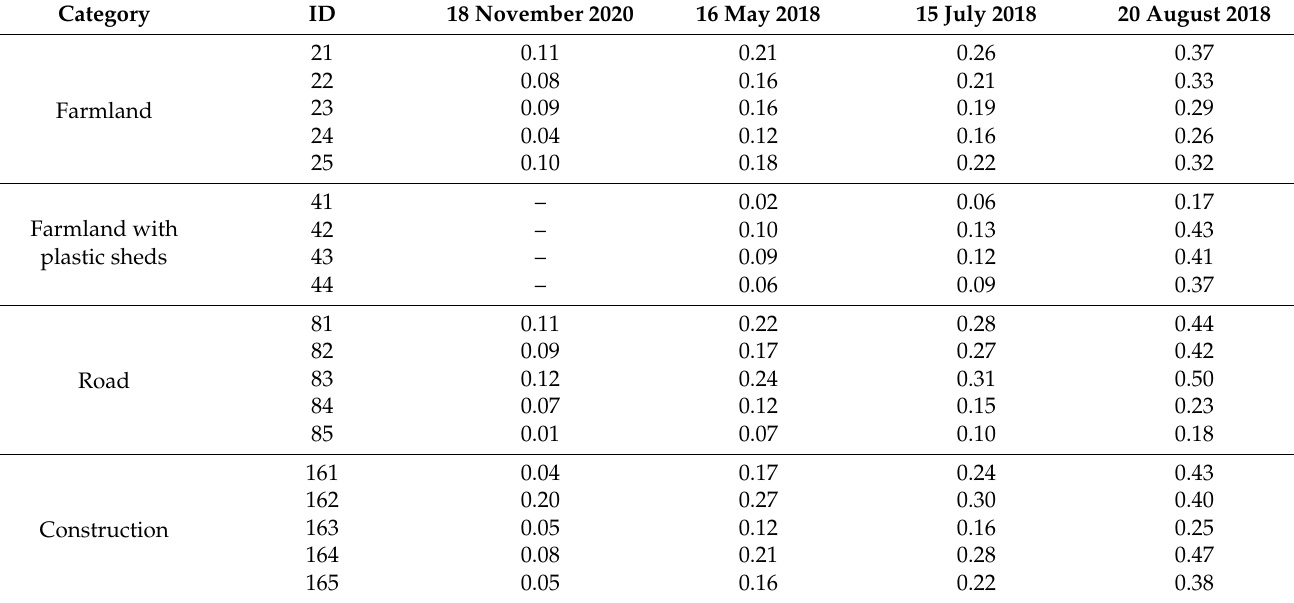
Table 7. Flood depths of sample points due to five rainfall events (Unit: